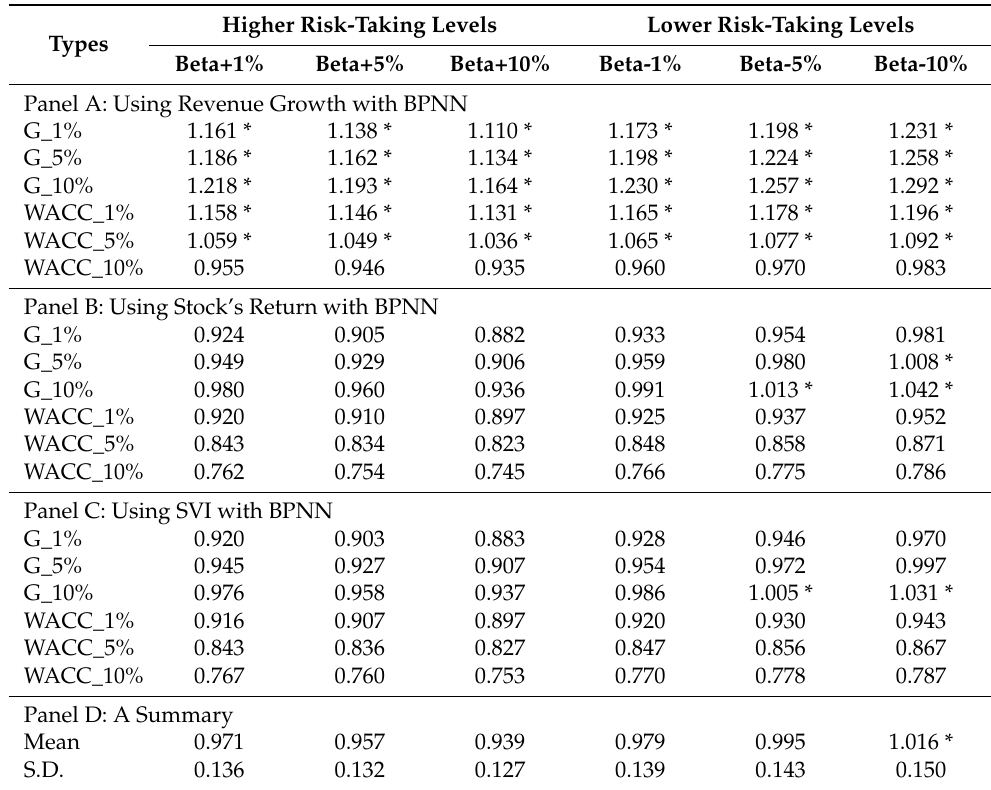
Table 9. Robust test of the changes in